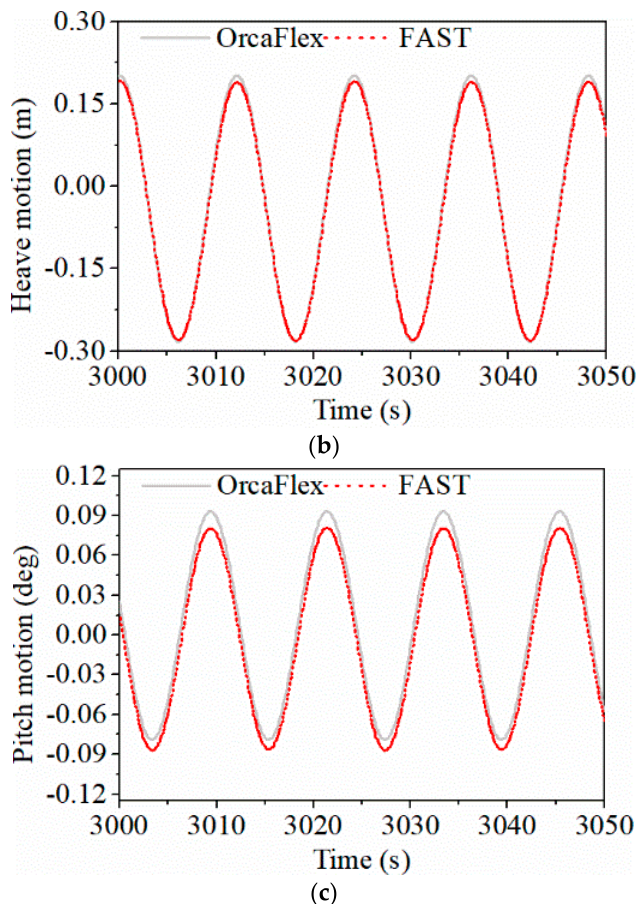
Figure 11. Comparison of WSA motions: OrcaFlex vs. FAST. ( a ) Surge motion; ( b ) Heave motion; ( c )Pitch motion